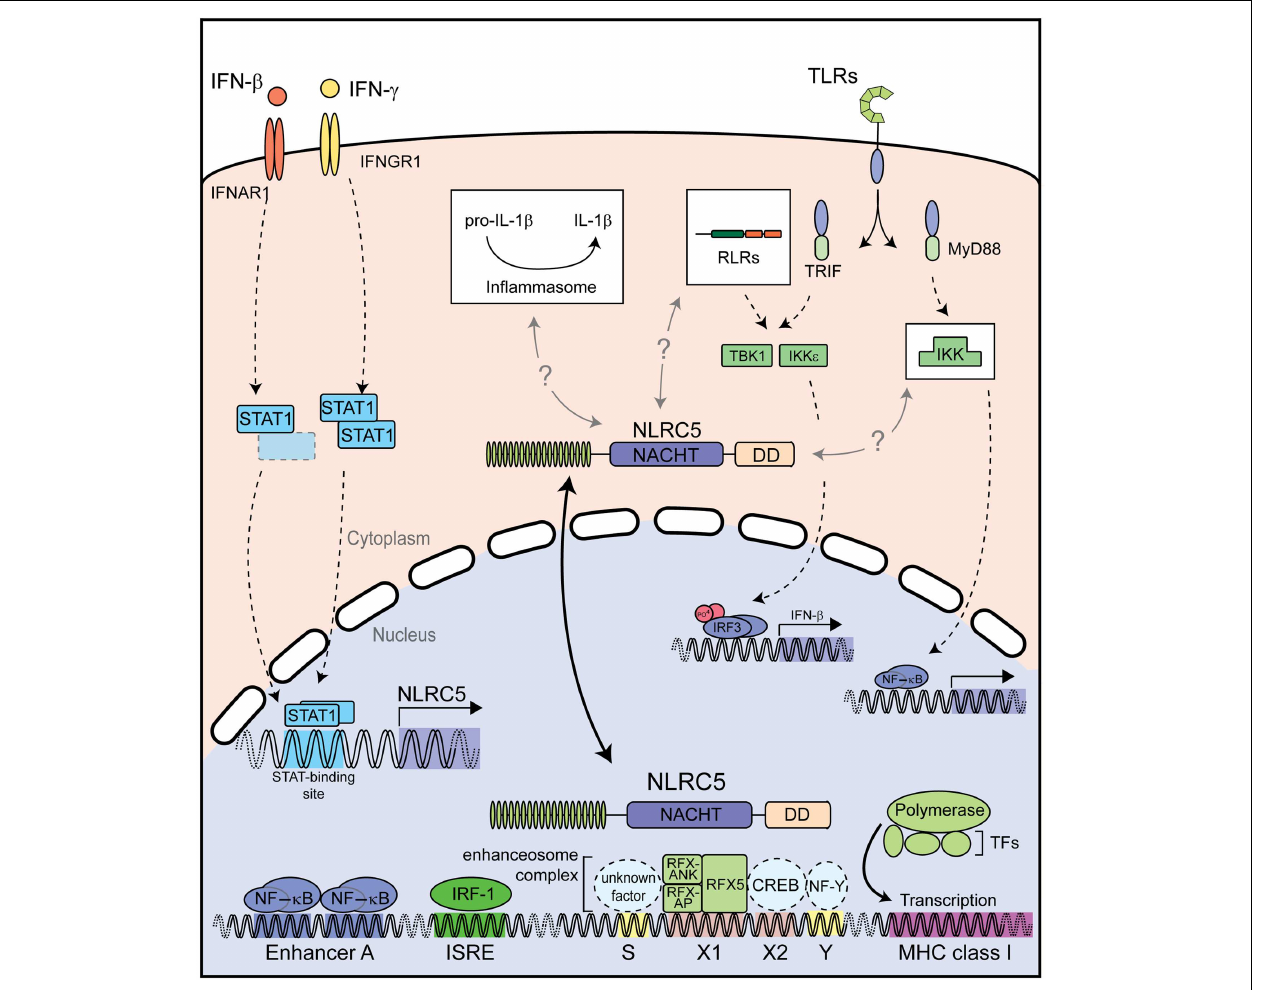
interferon regulator factor; ISRE, interferon stimulated response element; CREB, cAMP response element-binding protein; IKK, I κ B kinase complex; IKK ε , I κ B kinase subunit epsilon; NF-Y, nuclear factorY; RFX5, regulatory factor X 5; RFX-AP, RFX-associated protein; RFX-ANK, RFX-associated ankyrin-containing protein; RLRs, RIG-I-like receptors;TBK1,TANK-binding kinase 1;TFs, transcription factors;TLRs, toll-like